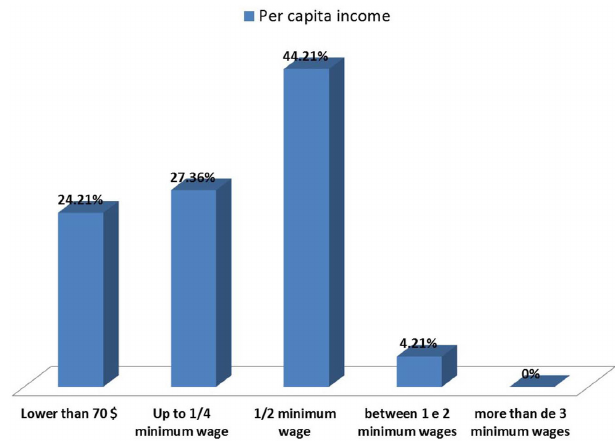
Fig. 2 - Per capita income of the families of the children with congenital cardiopathies in São Luís (2011 and first semester 2012).